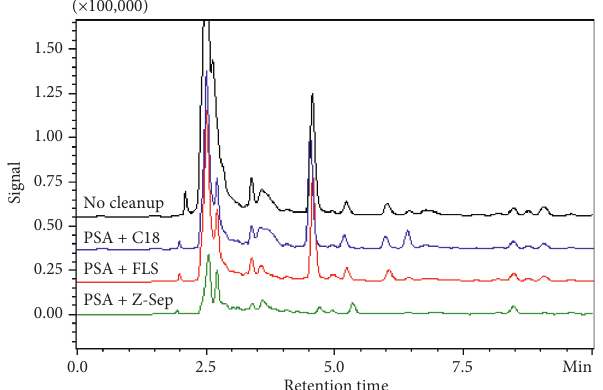
Figure 3: Matrix background of ginseng samples purified using different strategies indicated by HPLC-UVD.